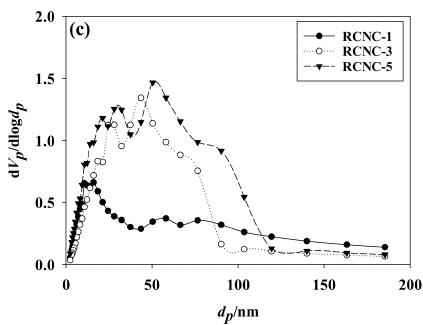
Figure 2. Pore size distribution of ( a ) RC and the manufactured composites, ( b ) RCCA (1, 3, and 5), and ( c ) RCNC (1, 3, ad